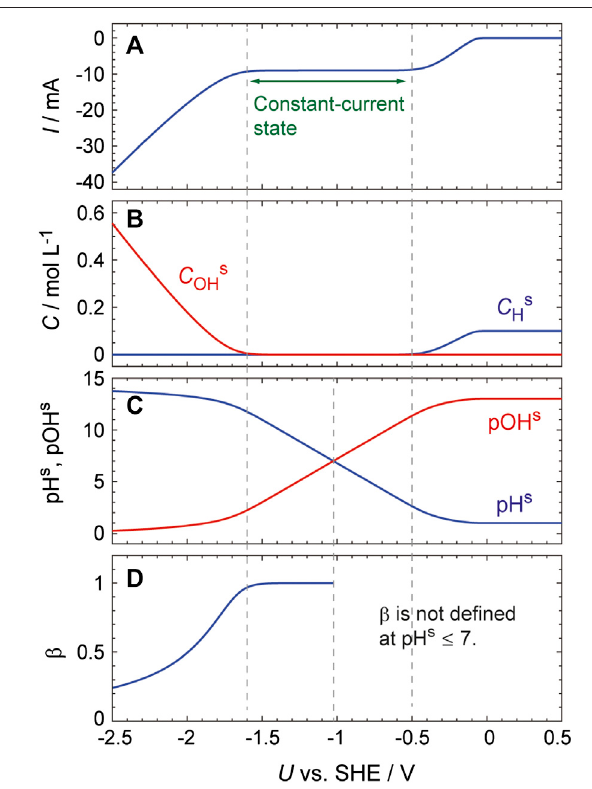
FIGURE 7 | Simulated curves generated using the same process as described in the caption to Figure 6 except that Eq. 17 wasused to calculate d C Hs /d t .